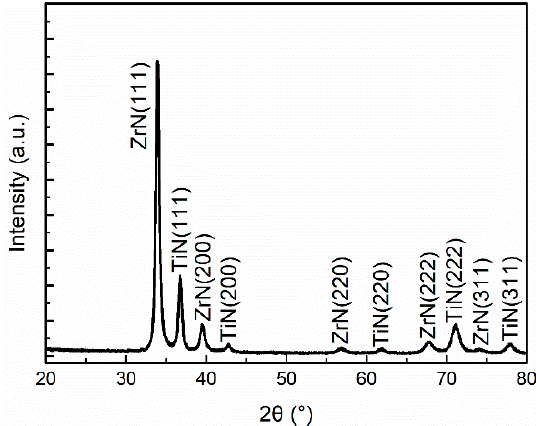
Figure 19. XRD diffractogram of TiN/ZrN coating after hot corrosion for 88 h.